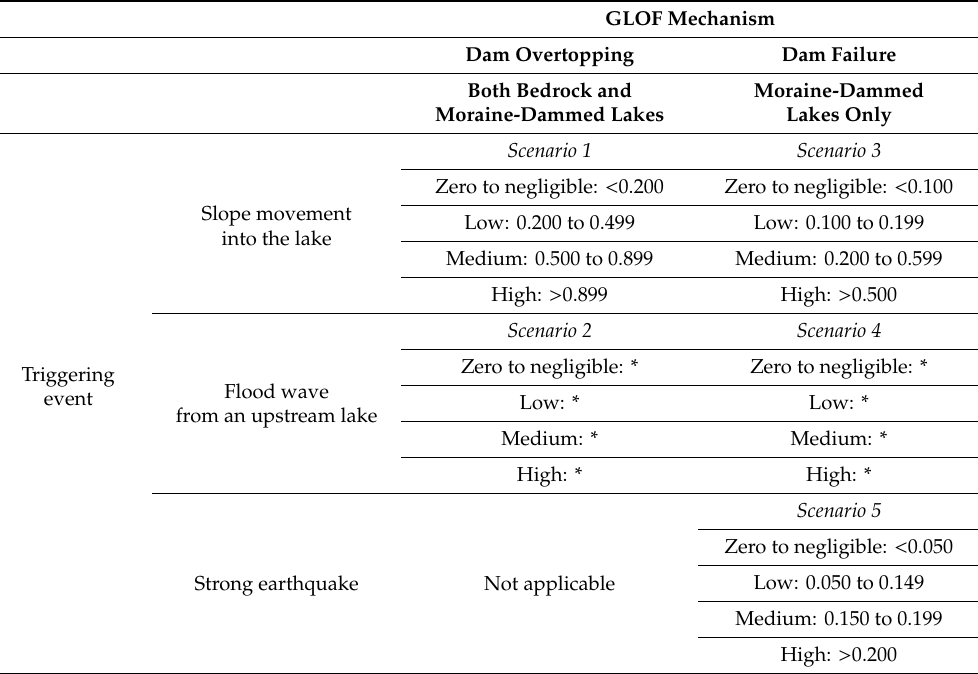
Table 1. FivescenariosconsideredinGLOFsusceptibilityassessmentandthresholdsofGLOFsusceptibility classes. Thresholds of individual susceptibility classes were derived from the analysis of previous GLOFs [34,39]. GLOF Mechanism Dam Overtopping Dam Failure Both Bedrock and Moraine-Dammed Moraine-Dammed Lakes Lakes Only Scenario 1 Scenario Slope movement into the lake